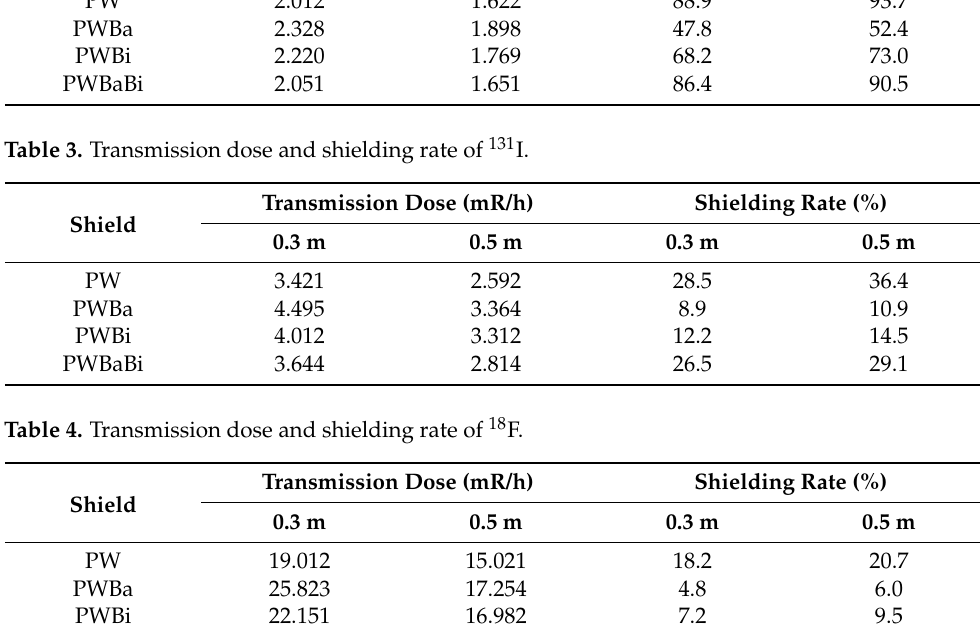
Figure 7. Description of the polymer encapsulation structure of tungsten particles. In this study, 99 mTc, 131 I, and 18 F were used as radiation sources to evaluate the nuclear medicine gamma-ray shielding performances of the shield sample and the syringe shield manufactured by the injection molding process. Table 1 lists the characteristics of the sources used. Table 1. Characteristics of nuclear medicine sailors.